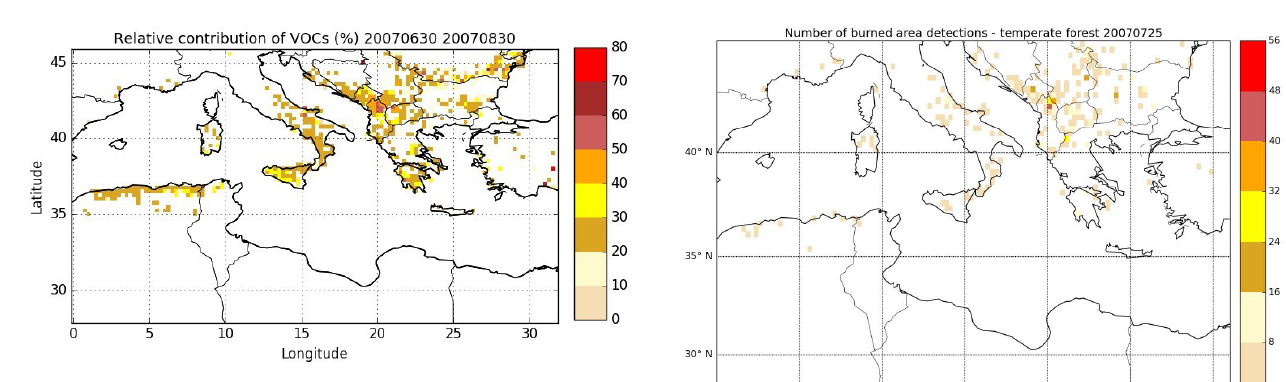
Figure 8. Relative contribution of VOCs to gaseous precursors (VOCs plus gaseous I/S/L-VOCs; %) emitted by wildfires over the Mediterranean area during the summer of 2007. Figure 9. Number of burned area detections for temperate forest on